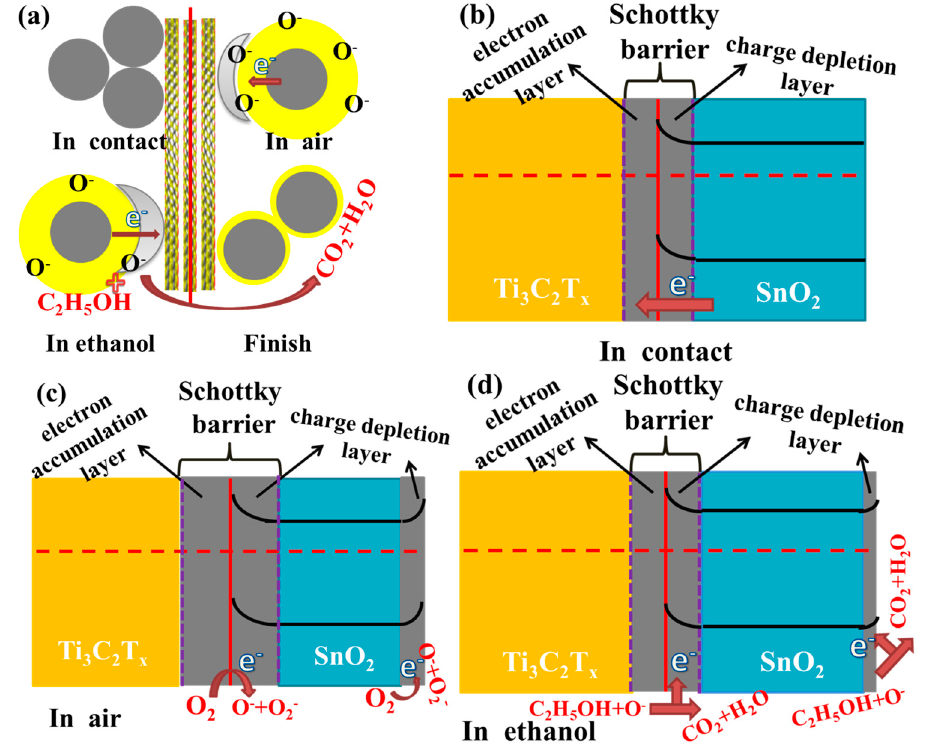
Figure 10. Schematic diagram of the sensitivity mechanism of the SnO 2 /MXene sensor. ( a ) An explanation of the whole process. ( b ) The formation and change process of composite materials. ( c ) Composite materials in the air. ( d ) Composite materials in the ethanol.